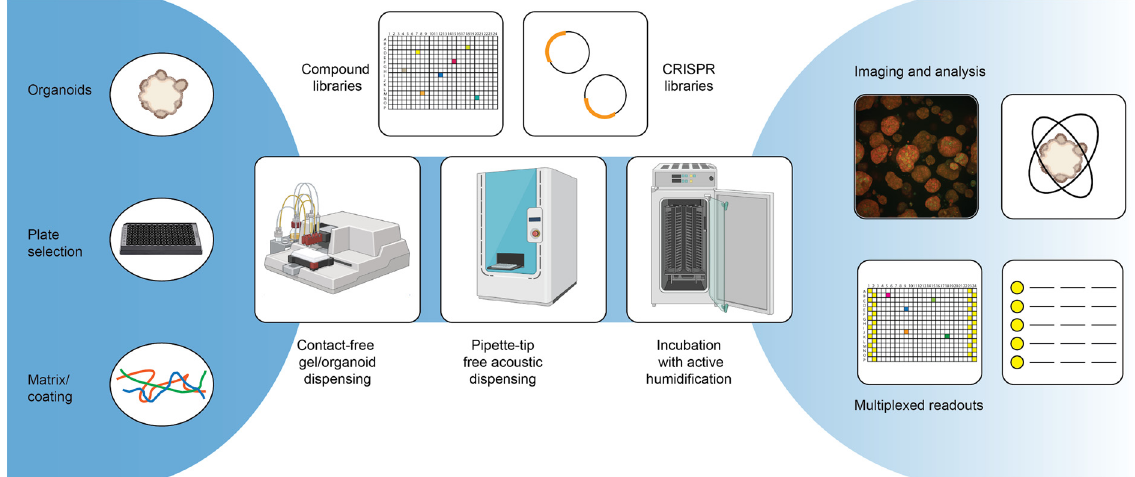
Figure 2. Advanced screening technologies.